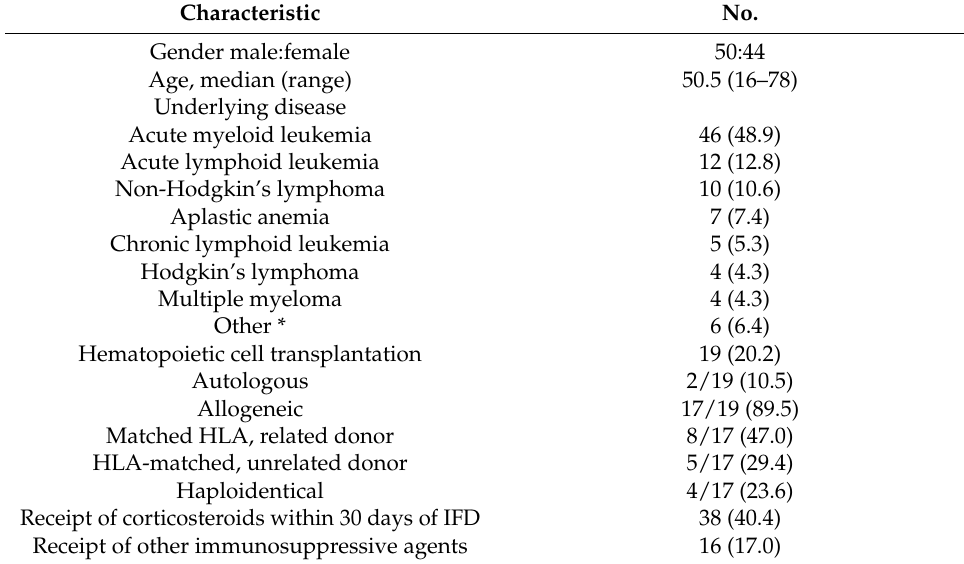
Table 1. Characteristics of 94 patients with invasive fungal